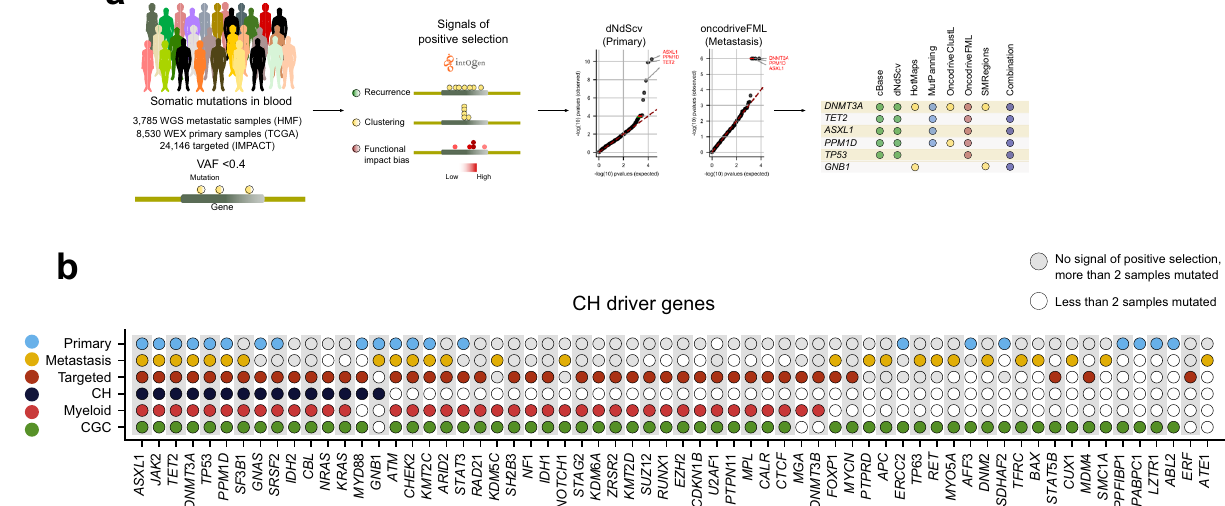
Fig. 2 Discovery of clonal hematopoiesis driver genes. a Summary of the discovery analysis applied to blood somatic mutations detected across primary, metastasis and targeted cohorts. The (differently fi ltered) sets of blood somatic mutations identi fi ed across all donors of a cohort were the input data for the analysis. Seven state-of-the-art driver discovery methods probing different signals of positive selection were applied (via the IntOGen pipeline) to each dataset of mutations. The distribution of expected and observed p-values (qq plots) for two of these methods (which implement parametric, non- parametric or empirical statistical tests described in the corresponding original articles) are represented in the panel. The IntOGen pipeline also handles the combination of the output of the seven methods to yield a uni fi ed list of CH driver genes in each cohort (details in Supp. Note 1). b CH driver genes discovered across the three cohorts. Genes known to be involved in CH, myeloid malignancies or tumorigenesis in general are labeled with different colors (denoted at the left of the plot). The union of the lists of CH drivers discovered in these three cohorts (64 genes) integrate the CH drivers compendium presented in Supplementary Data fi le 2 and available through www.intogen.org/ch. IMPACT: targeted cohort, CGC cancer gene census. Source data for panel b are provided as Source Data fi